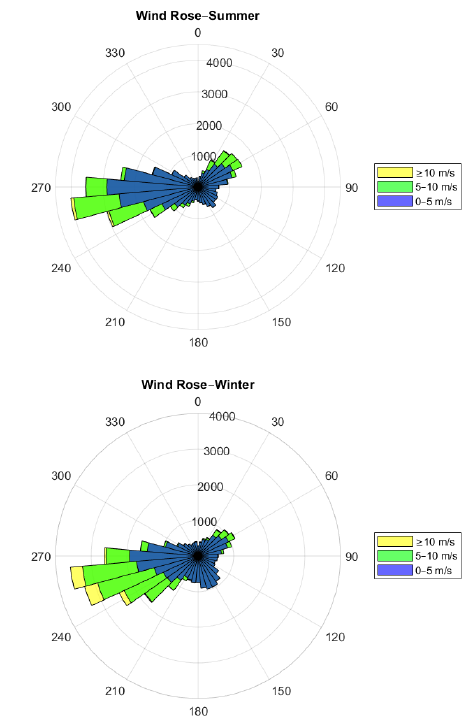
Figure 3. Wind rose diagram for the whole studied period 2005–2021.